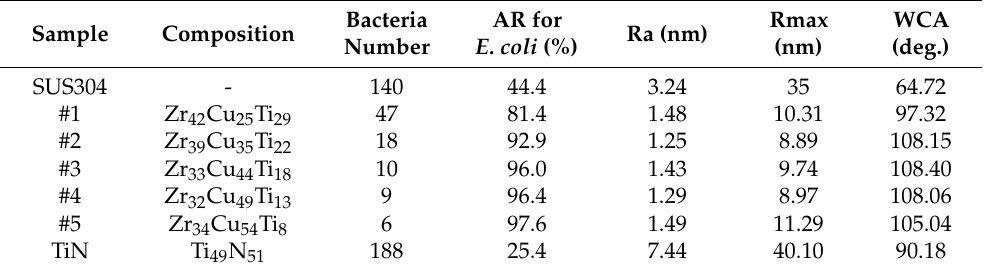
Figure 9. Number of E. coli colonies and water contact angle on Zr-Cu-Ti, TiN, and SUS304 samples (insets show photographs of E. coli colonies on MHA dishes). Table 2. Roughness, bacteria number, water contact angle, and antimicrobial rate of SUS304, Zr-Cu-Ti TFMGs, and TiN